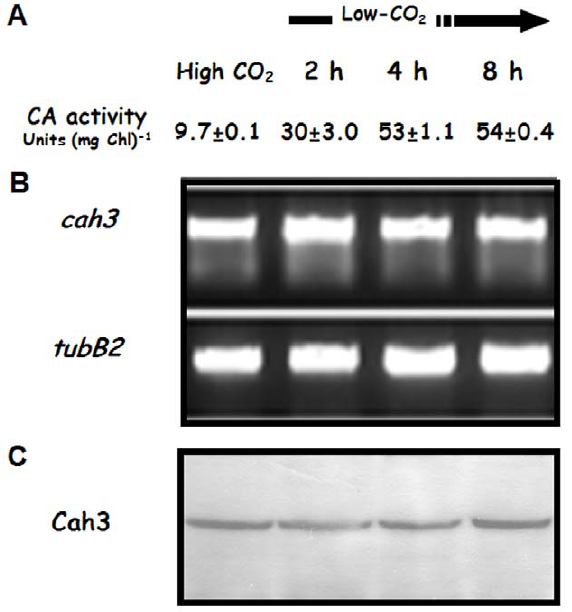
Figure 1. Analysis of thylakoid carbonic anhydrase (Cah3) activity and expression during the acclimation of high-CO 2 - grown C.reinhardtii cells to low CO 2 conditions. ( A ) CA activity (WA units (mg Chl) 2 1 ) was measured in thylakoid membranes isolated from high-CO 2 -grown cells or acclimated to low CO 2 for 2, 4 and 8 h. Values are means 6 SE ( n =5). ( B ) Semiquantitative RT-PCR analysis of Cah3 gene expression. Total RNA to be used for RT was isolated by using Trizol TM reagent according to the manufacturers protocol (Life Technologies, US). Aliquots of the reaction mix were loaded and ethidium bromide stained in 1% agarose gels. ( C ) Immunoblot analysis of total cell extracts from cells of C. reinhardtii with antibodies raised against over-expressed Cah3 polypeptide. The lanes were loaded with 10 m g protein. labelling and mass-spectrometric techniques [19], [20]. Our data